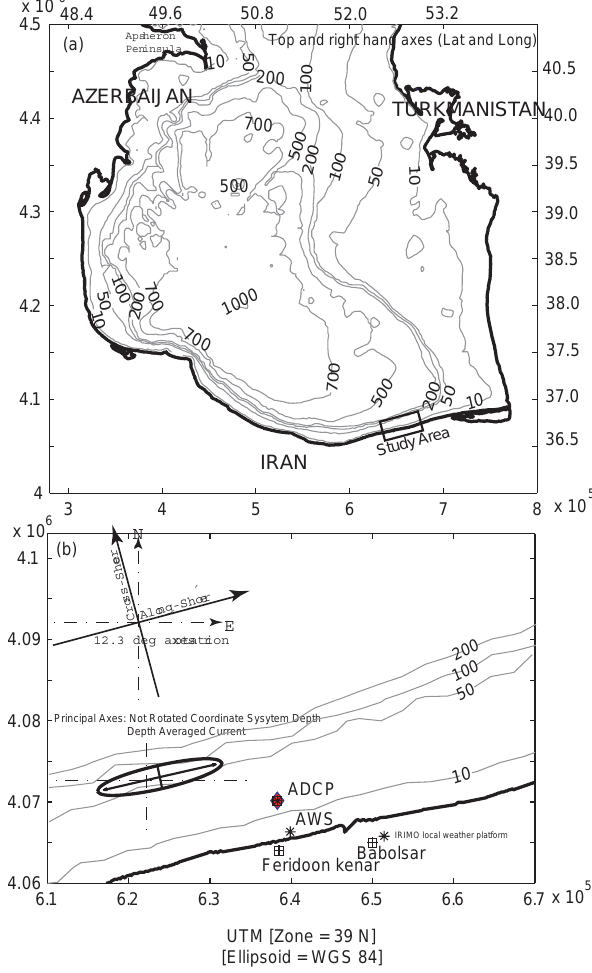
Fig. 1. Location map showing field